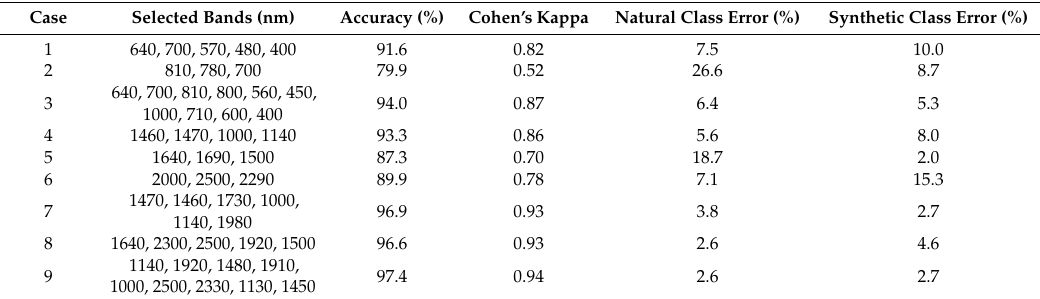
Table 4. Leave-one-out classification performance between natural and synthetic dye class considering spectra of all the